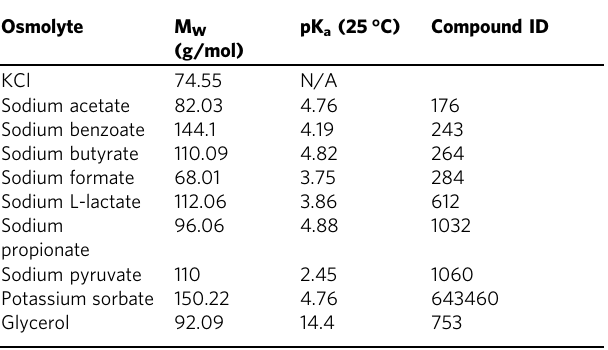
Table 2 Molecular Weight and pK a values of the used